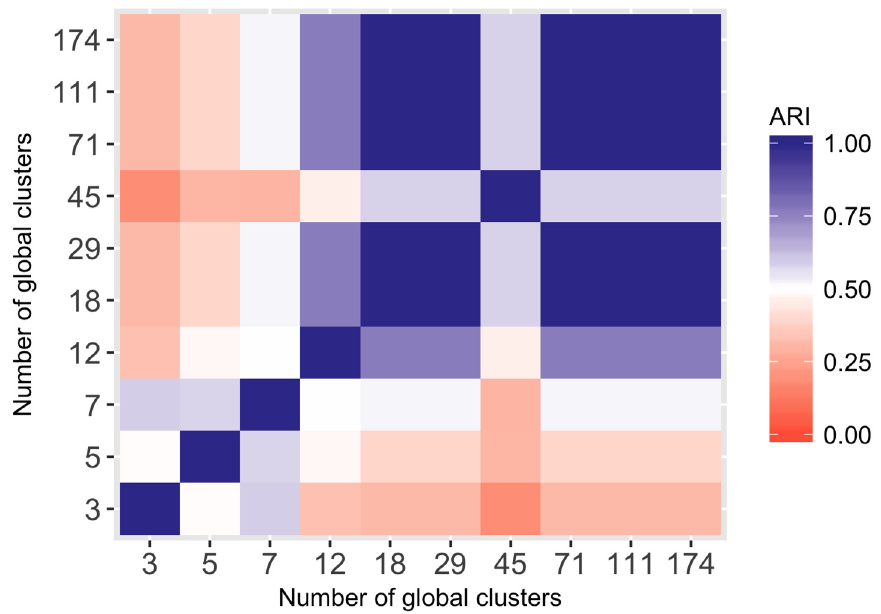
Fig 13. Consistency between global clustering results for different number of global clusters with 3 context-specific clusters, as measuredby the ARI.